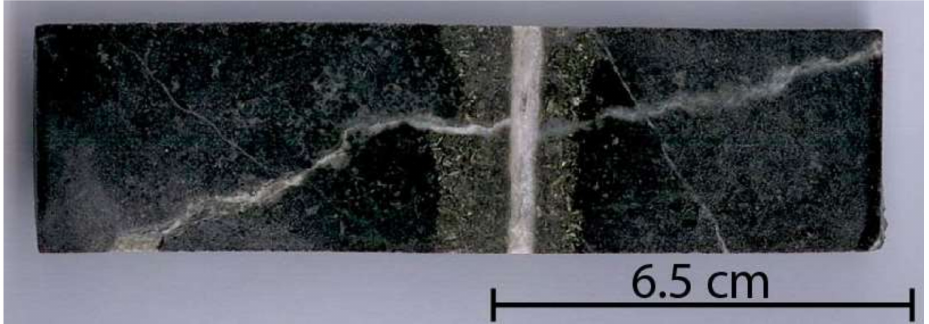
Figure 5. Photograph of drill core slab displaying a lamprophyre dyke cross-cut by a quartz vein and its associated alteration envelope (sample 80-12).